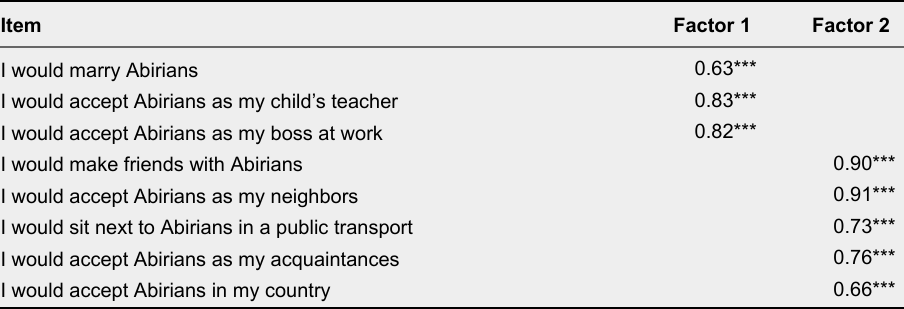
Factor Loadings of the Confirmatory Factor Analysis (CFA) Two-Factor Solution for the Social Distance Scale (Revised) Item Factor